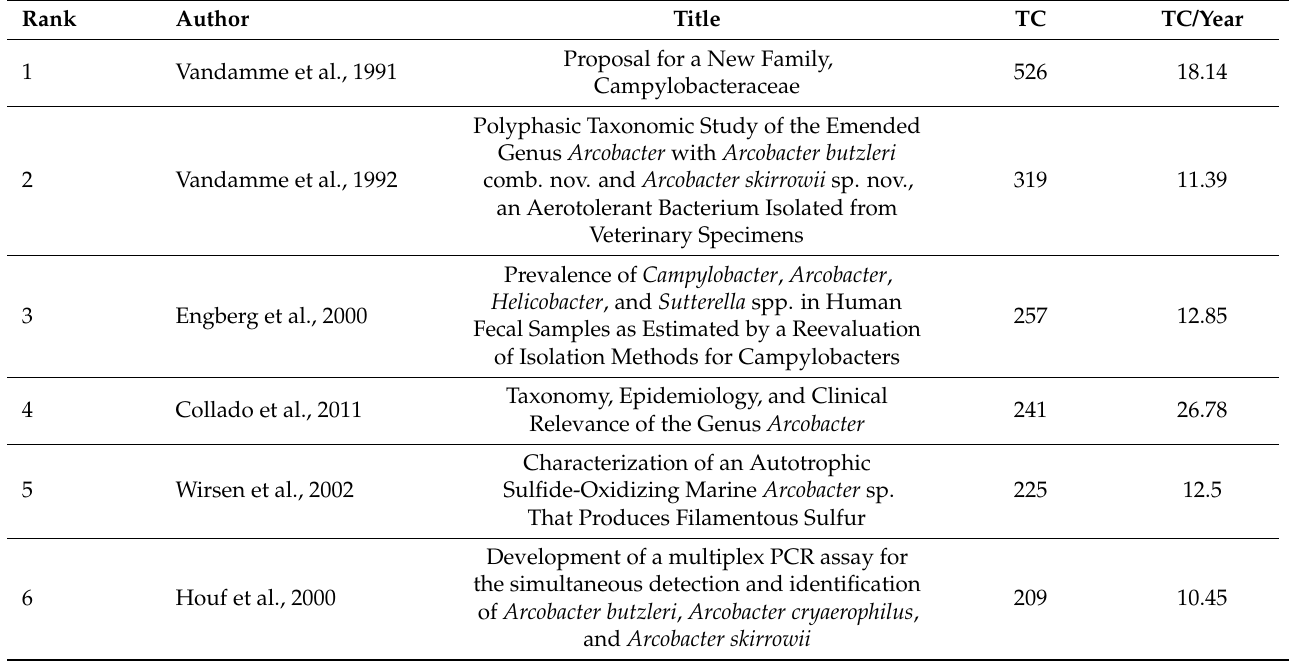
Table 4. Top articles per